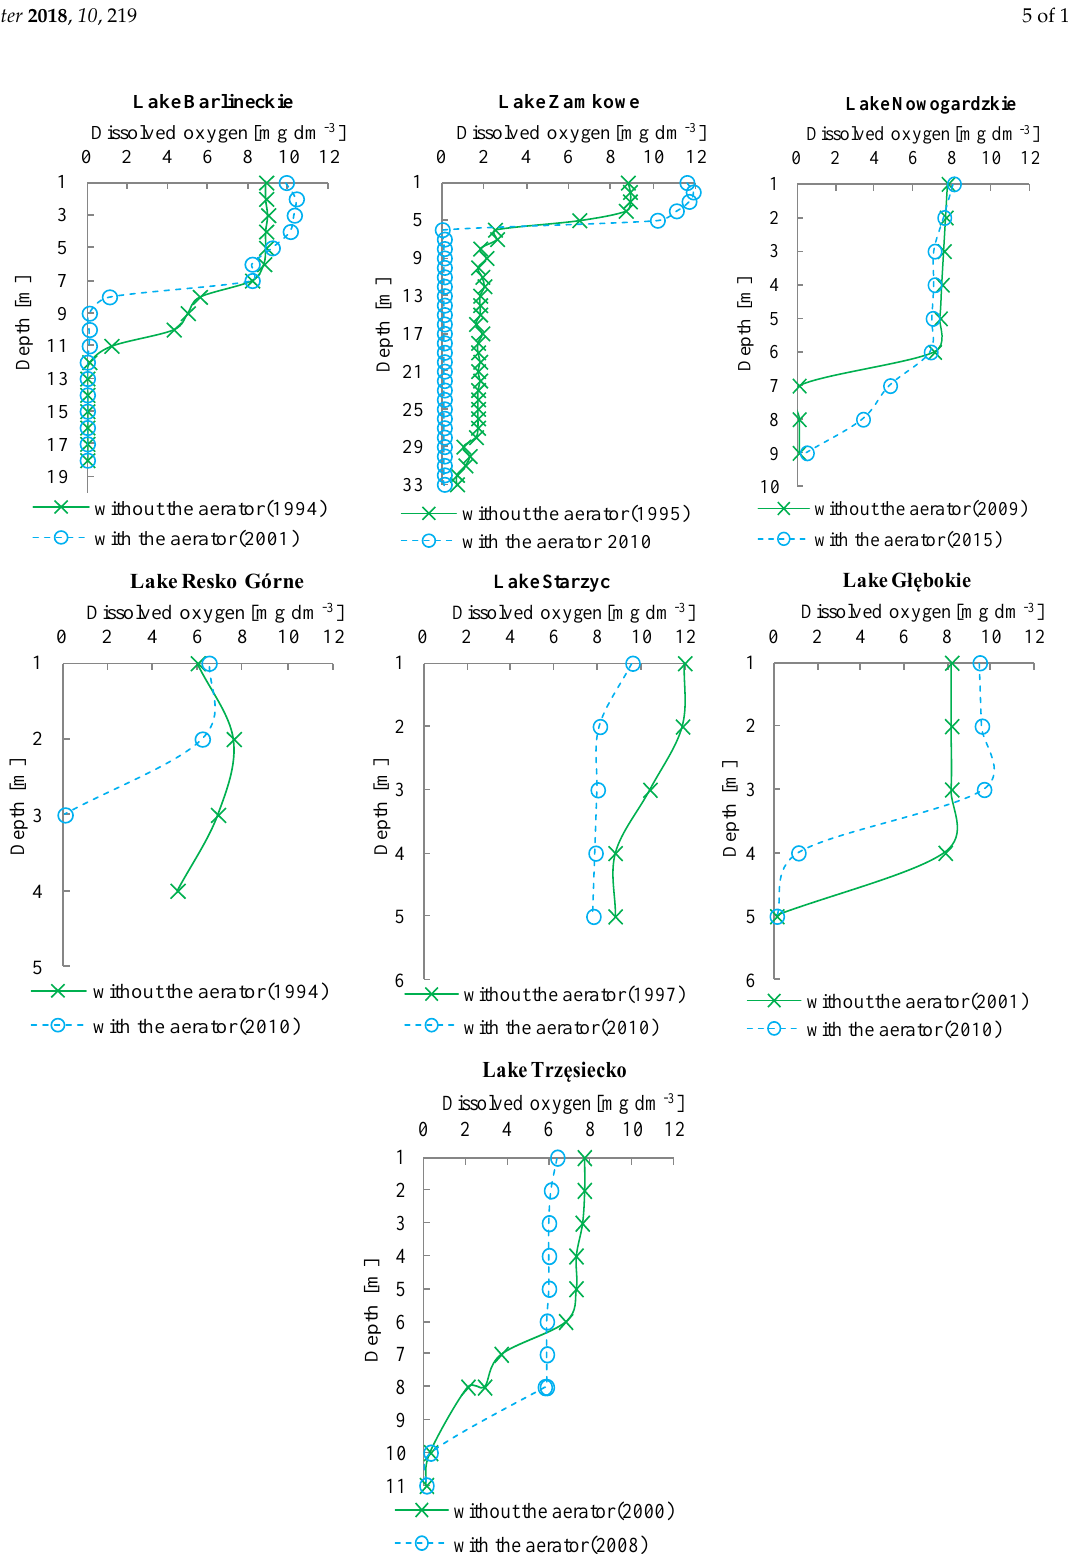
Figure 1. Example vertical profile of dissolved oxygen concentration in the water column at the deepest site of the lakes, in the summer season, before and after installation of the aerator. In the analysed lakes, the lowest development of phytoplankton biomass was found in Lake Barlineckie; the mean CHL content calculated for all the analysed years amounted to 6.0 mg m −3 . The highest biomass development was found in Lake Starzyc, with a mean of 44.3 mg m −3 . In most of the analysed lakes, in the summer season, before deployment of the aerator, the TN:TP ratio was <10 (Table 2), which shows that nitrogen was the the most growth-limiting nutrient. The exception was